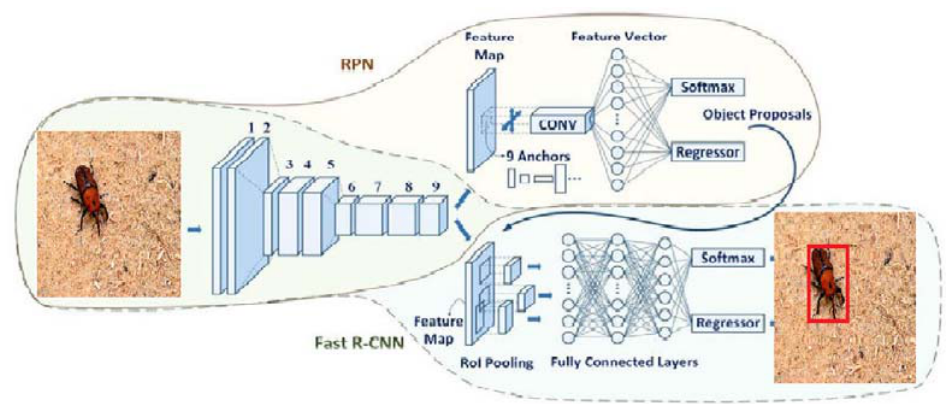
Figure 1. Proposed framework for the developed model. Deep learning is a state ‐ of ‐ the ‐ art approach to classifying and identifying objects. Object detection automatically identifies the selected part of an image with the RPW. In the proposed method, faster R ‐ CNN is used to detect the RPW and classify the species. The individual parts of an image are identified as enclosed in a selectable bounding box, and a class label is assigned to the RPW part of the image. The faster R ‐ CNN architecture consists of three major components, namely a convo ‐ lutional layer (CNN), a region proposal network (RPN) and a class/bounding box detec ‐ tion mechanism. The CNN layer helps to discover the features of an image from data. The RPN works as a sliding window over the feature maps that have been extracted by the CNN. The last module, faster R ‐ CNN, helps detect the bounding box of an object and the object itself. The whole mechanism of the architecture is explained in Figure 2. Two ‐ di ‐ mensional images are passed to the CNN module, which detects multiple regions by us ‐ ing the sliding window of the CNN module to obtain a feature map (feature size: 60, 40, 512). In order to extract the feature vector, we applied the ROI region proposal to each region proposal. The output from the ROI pooling layer had a size of (N, 7, 7, 512), where N represented the number of proposals. The ROI layer helped in finding the exact coordi ‐ nates/location of an object as well as categorizing the object as RPW or not. Figure 2. Block diagram of the proposed real ‐ time system.